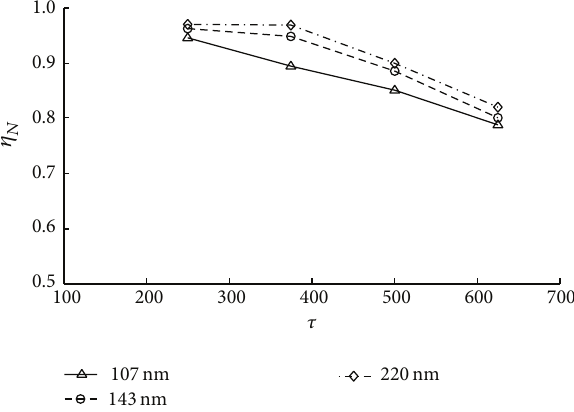
Figure 5: Penetration efficiencies for different 𝜏 at Re = 1412.